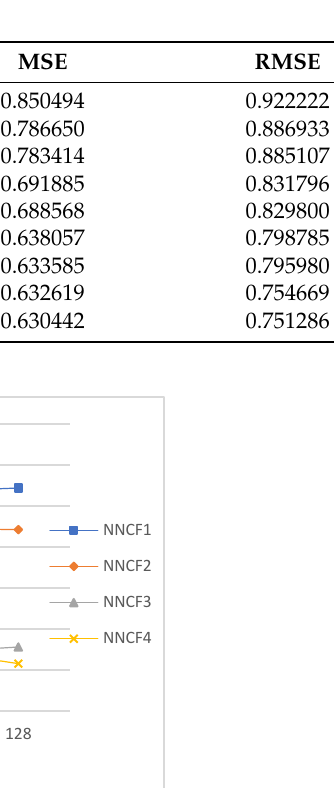
Table 6. The performance for the NNCF predictors.